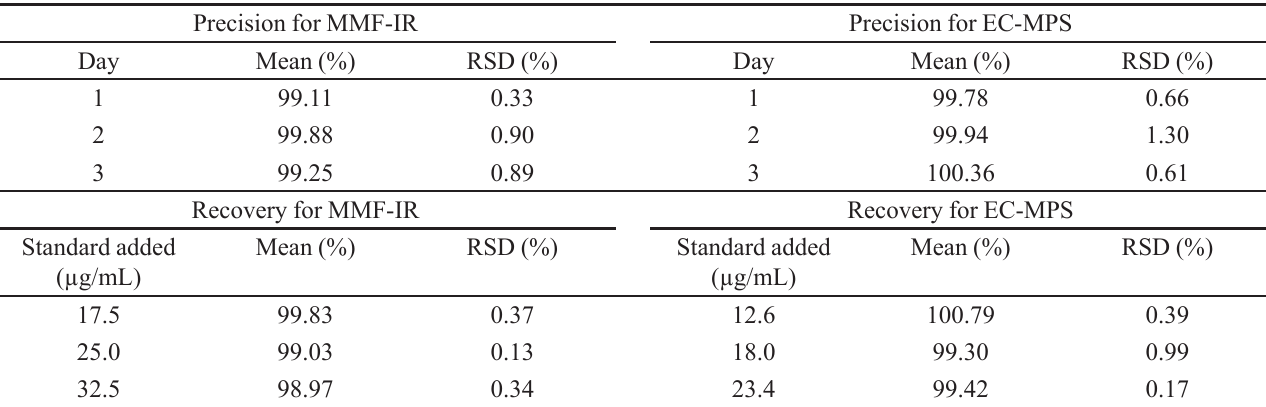
TABLE VII - Precision (n=18) and recovery (n=12) data for MMF-IR and EC-MPS tablets, in selected media 0.1 M HCl and PBS pH 6.8, respectively, using UV method, λ 250 nm Precision for